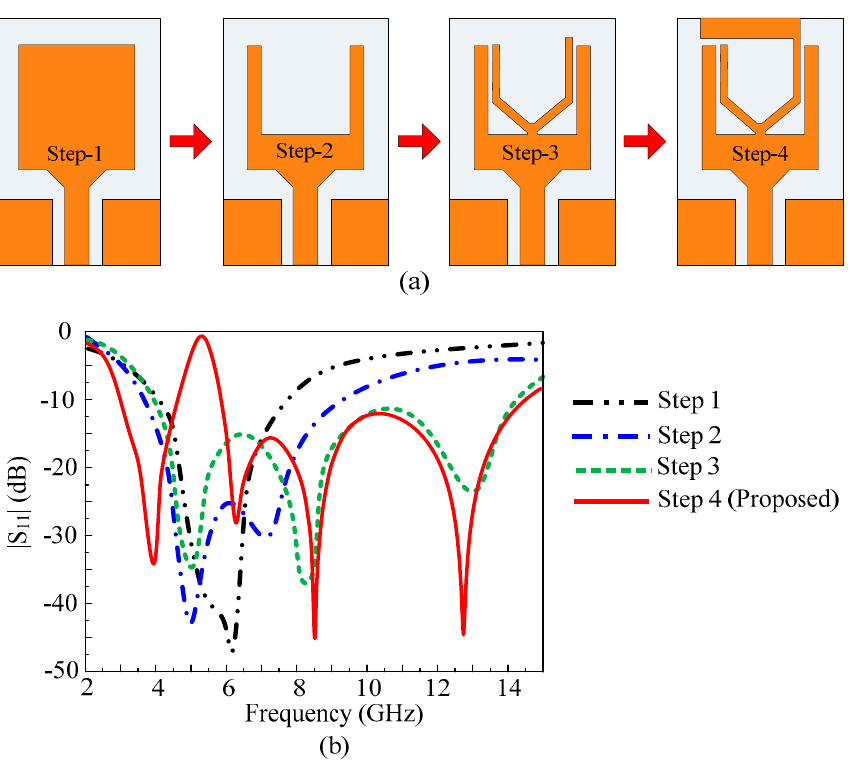
Figure 2. Proposed antenna’s ( a ) various design steps. ( b ) |S 11 | responses.